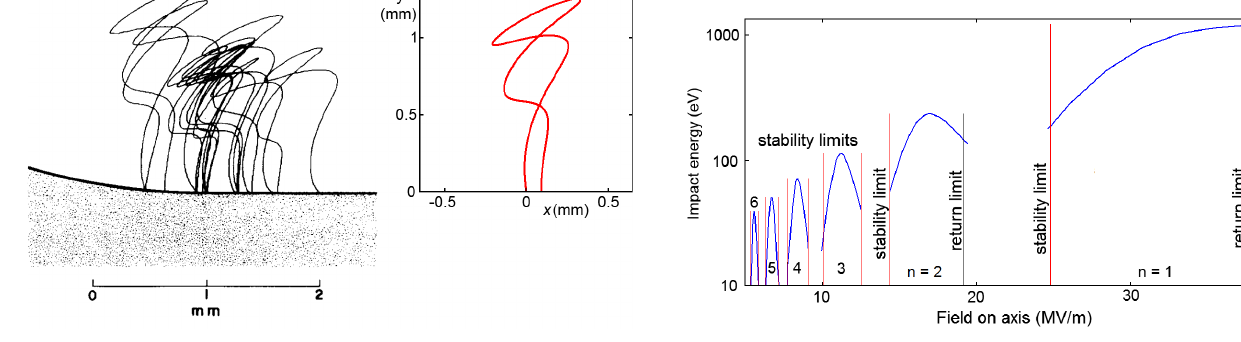
FIG. 5. Example of electron orbits from [1] for third-order MP and a solution of Eq. (4) for the geometry from Fig. 1.